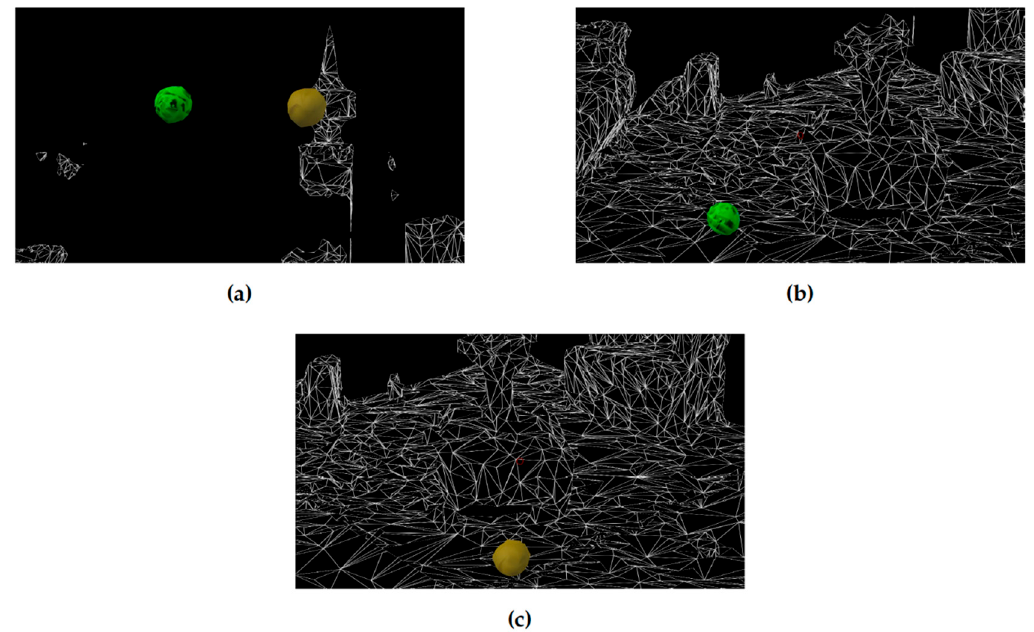
Figure 2. Basic design of the game where one ball is the target while another is the non-target. Above images are before and after hitting the target ball or the wrong ball: ( a ) Initial screen, ( b ) Dropping the correct ball, and ( c ) Dropping the wrong ball.